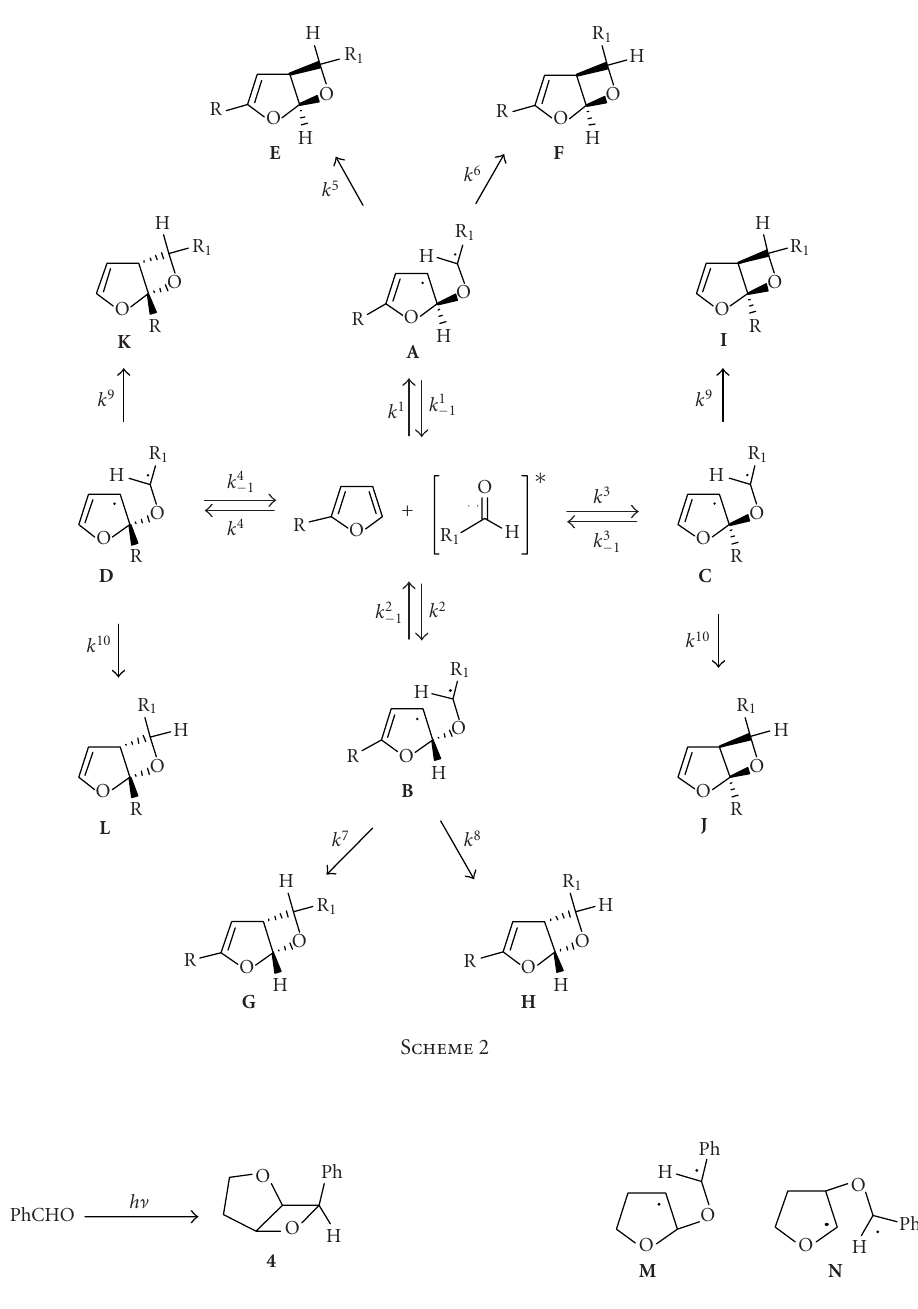
Figure 1: Possible biradical intermediates in the reaction of 2,3- dihydrofuran with